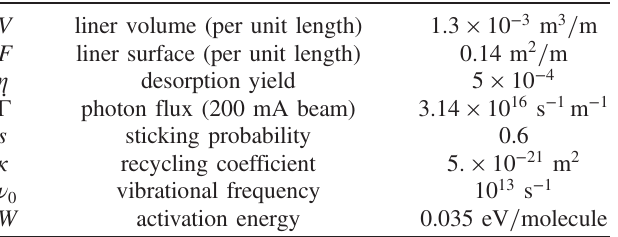
TABLE II. Typical values of the parameters in (14) from [35].